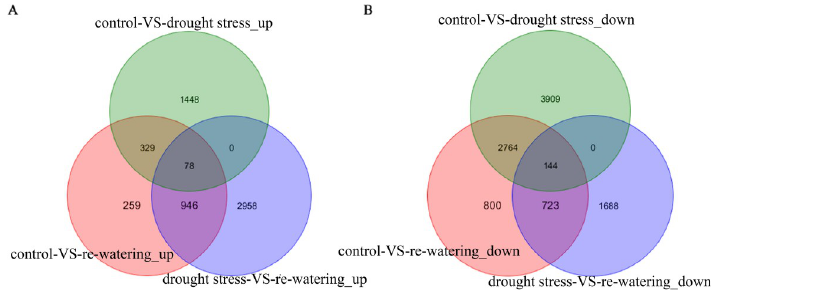
Fig 3. Venn diagram analysis of differentially expressed genes.